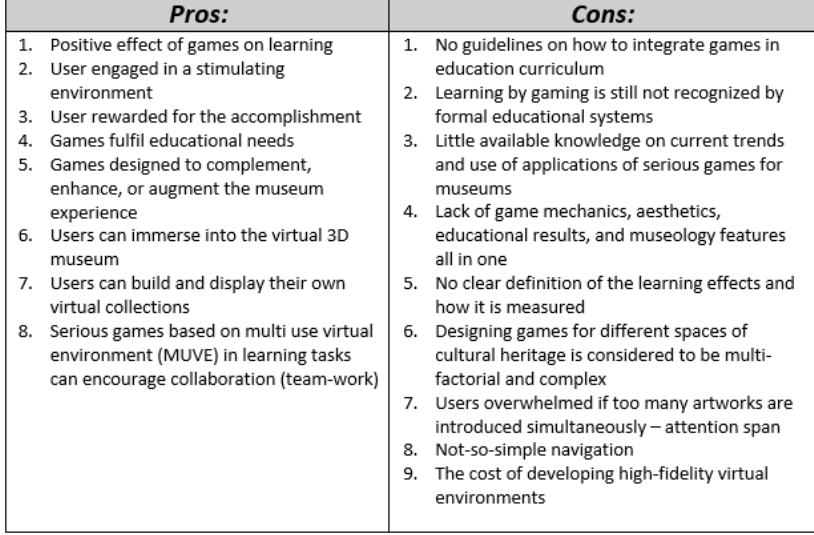
Figure 2. The summary of the main